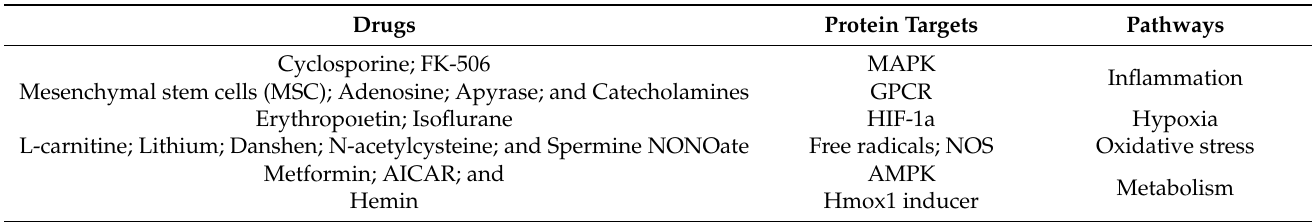
Table 1. Examples of pharmacological renal ischemic preconditioning in rodents. MAPK: mitogen- activated protein kinases; GPCR: G protein-coupled receptor; HIF-1: hypoxia-inducible factor 1; NOS: nitric oxide synthase; and AMPK: AMP-activated protein kinase (adapted from [23]). Drugs